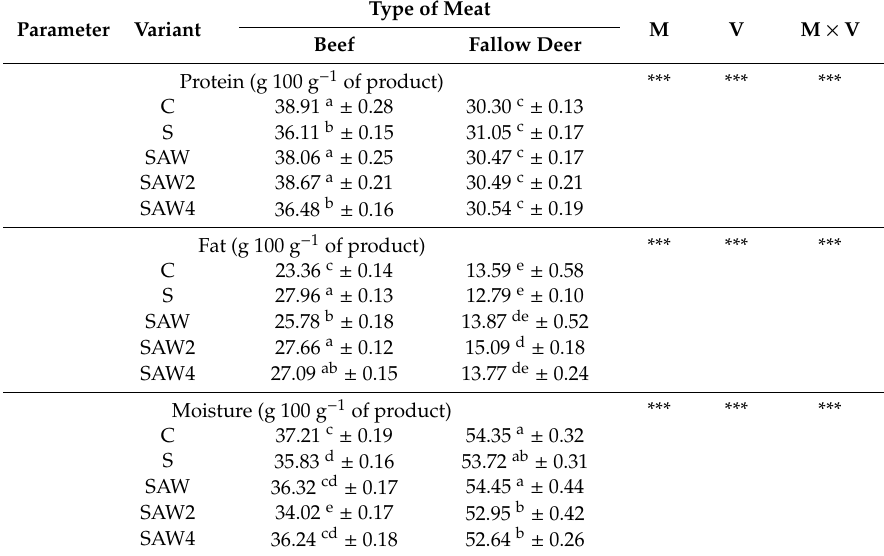
Table 2. Composition of fermented sausages (% w / w ) made from fallow deer and beef meat with di ff erent additives (mean ± standard